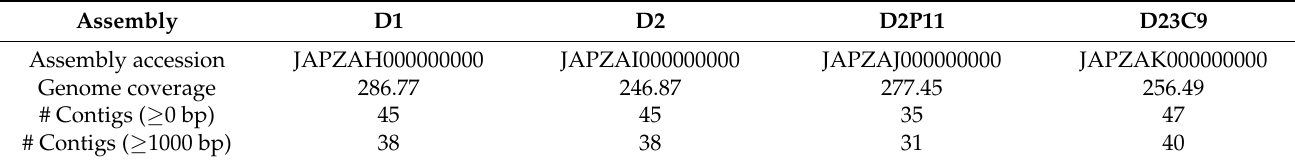
Figure 1. Oxacillin population analysis profile and area under the curve (PAP-AUC) of bacterial strains included in this study. Serial 10-fold dilutions of cultures were plated onto Mueller–Hinton agar with oxacillin (OXA). Each point represents the viable count (log10 CFU/mL) after 48 h against increasing concentrations of OXA. 2.2. general genomic features. Table 2. Accession numbers, genome coverage and assembly metrics of genomes included in this study. # Contigs is the total number of contigs in the assembly. # Contigs ( ≥ x bp) is the total number of contigs of length ≥ x bp. Largest contig is the length of the longest contig in the assembly. Total length is the total number of bases in the assembly. Total length ( ≥ x bp) is the total number of bases in contigs of length ≥ x bp. GC (%) is the total number of G and C nucleotides in the assembly, divided by the total length of the assembly. N50 is the length for which the collection of all contigs of that length or longer covers at least half (50%) the total base content of the assembly. N90 is used for the same purpose but the length is set at 90% of total base content instead of 50%. L50 is the number of contigs equal to or longer than the N50 length. L90 is used for the same purpose in reference to